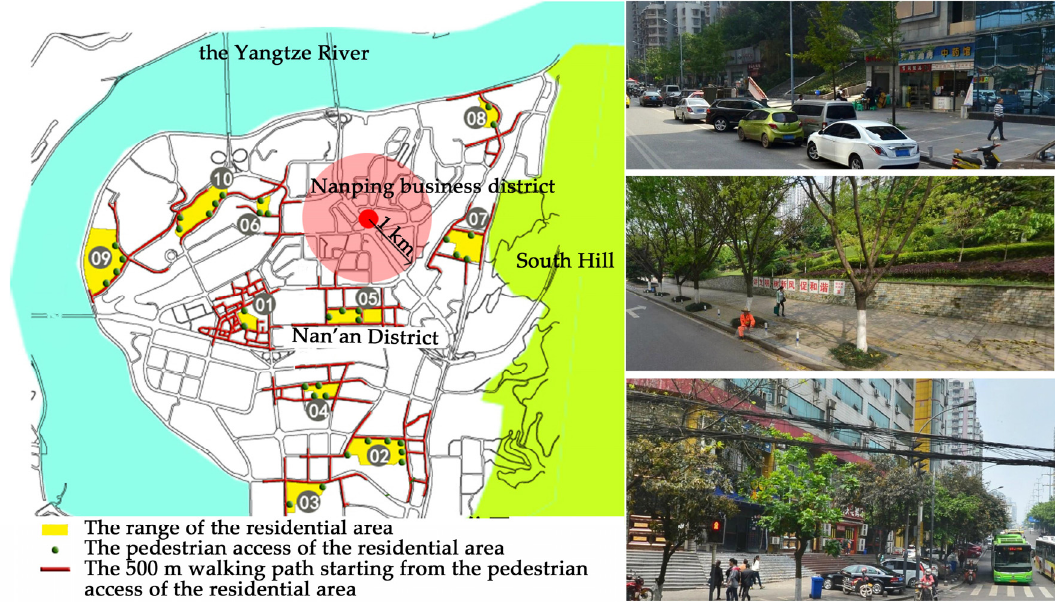
Figure 1. Sample residential areas.